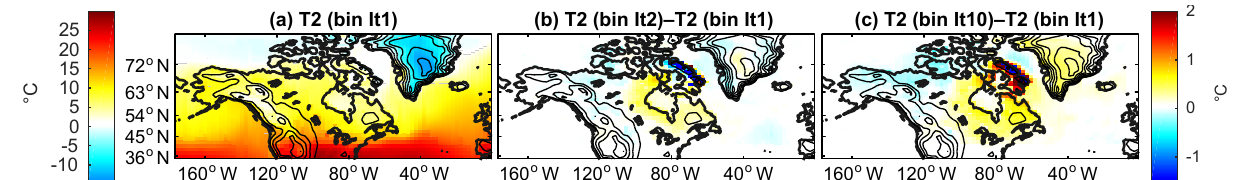
Figure 9. Summer 2m temperature in the parent domain in select iterations: (a) the 2m temperature for Iteration 1 and (b–c) 2m temperature differences during the summer between Iteration 1 and iterations 2 and 10.